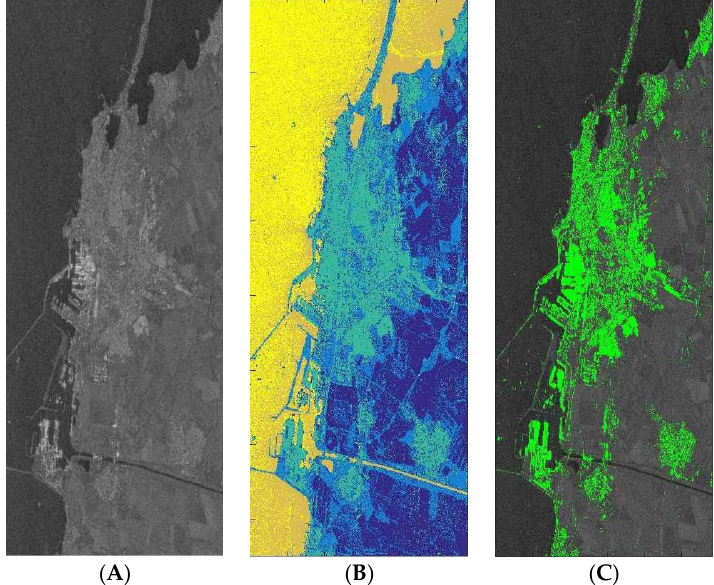
Figure 13. Multi-look Sentinel-1 image amplitude, Constanta ( A ); Scene classification map presenting categories of evolution ( B ); spatial distribution of detected Persistent Scatterers ( C ).